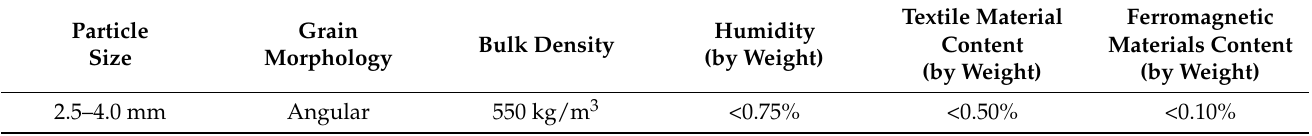
Table 2. Physical properties of recycled crumb rubber from end-of-life tyres.